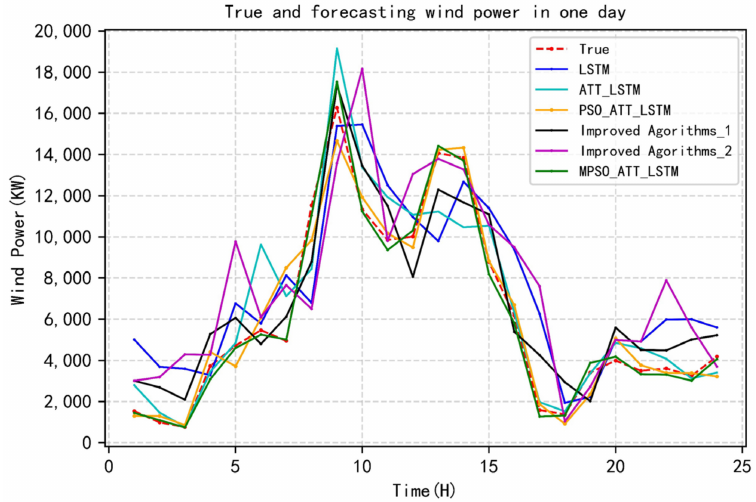
Figure 10. Wind power prediction